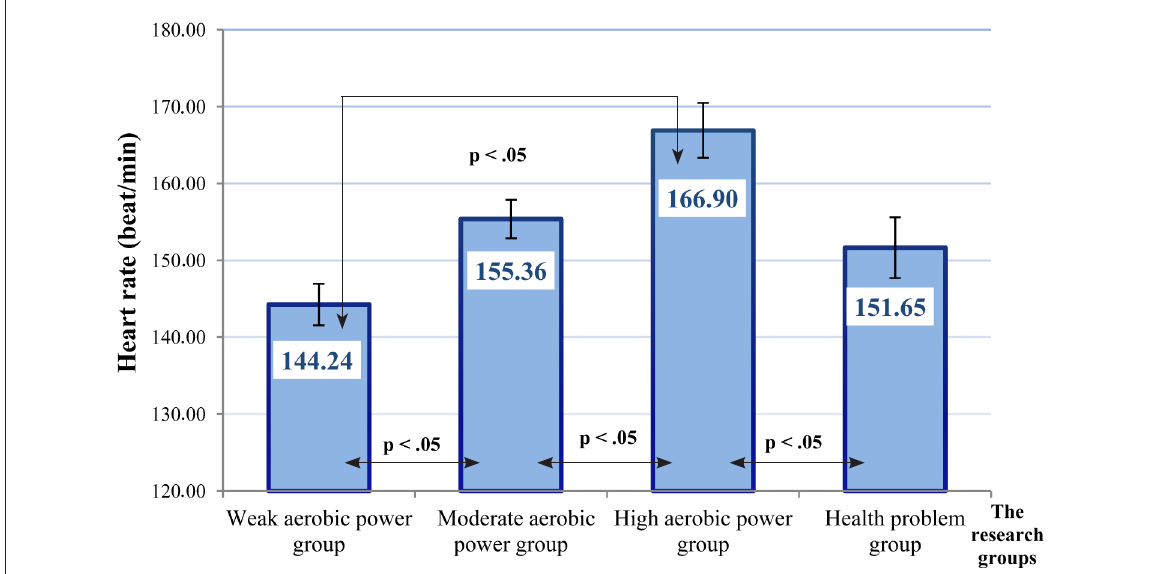
Note. p < .05 – statistical difference between groups. Figure 4. Heart rate at the anaerobic threshold during bicycle